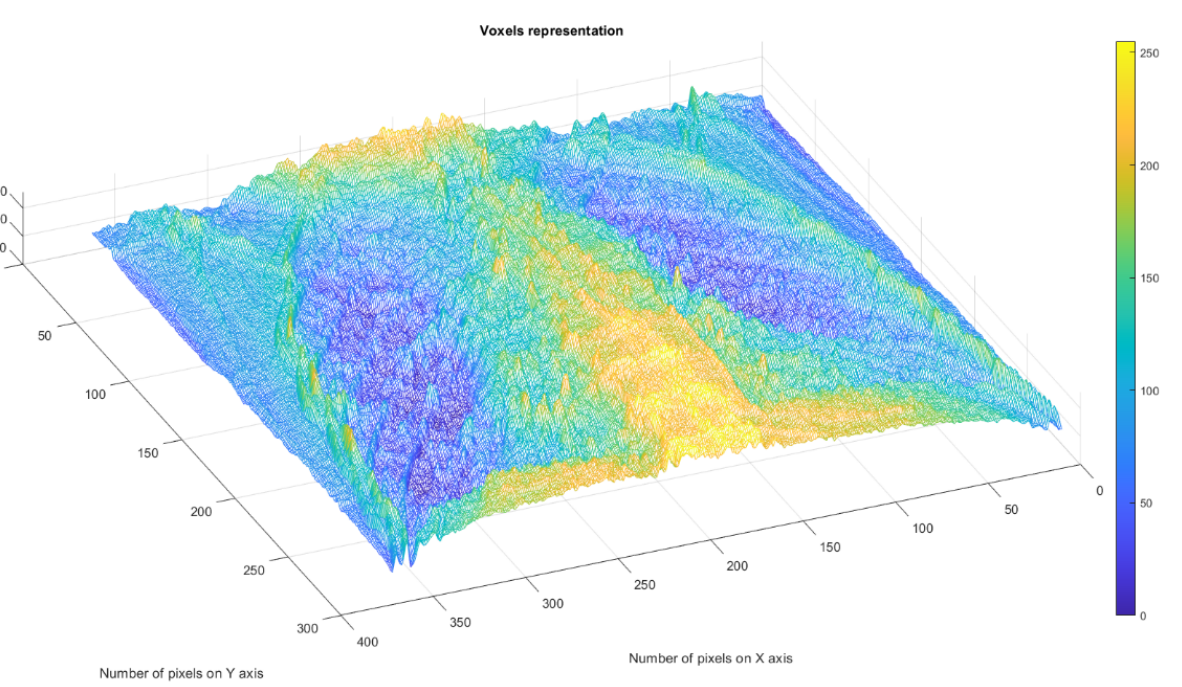
Figure 20. De fi ning the mask for the right lung of the fourth patient.